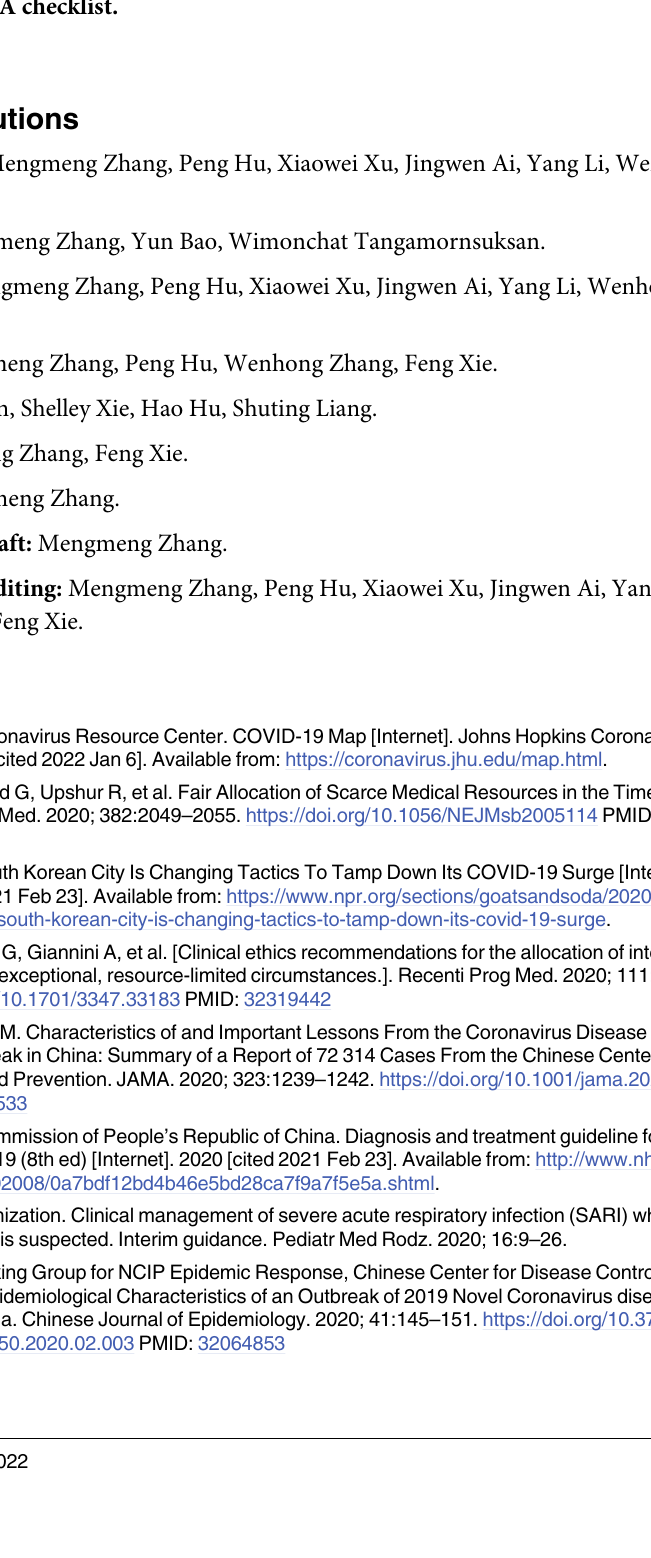
China. Fig C Length of hospital stay among patients with severe vs critical COVID-19. Fig D Discharge rate among patients with severe vs critical COVID-19. Fig E The use of invasive ven- tilation rate among patients with severe vs critical